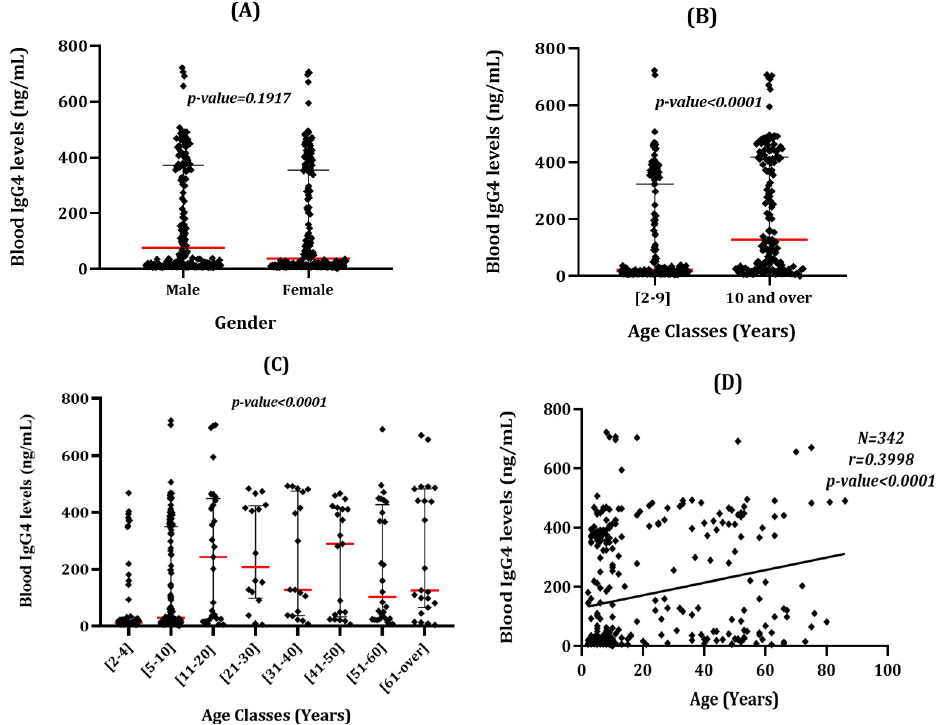
Fig 2. Distribution of IgG4 levels in the study population according to gender and age classes. (A) Distribution of IgG4 between males and females. (B) Distribution of IgG4 between individuals aged < 10 and those aged 10 years and over; (C) Distribution of IgG4 levels within the different age classes; (D) Correlation between IgG4 levels and age. IgG4 levels were determined using the normalized OD.